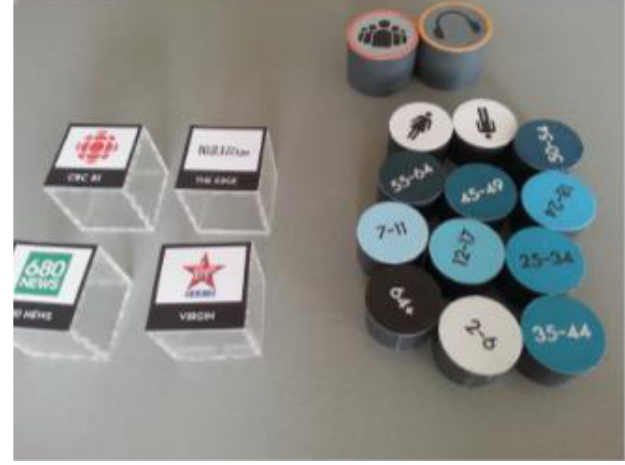
Figure 30. Tangible objects for creating data queries